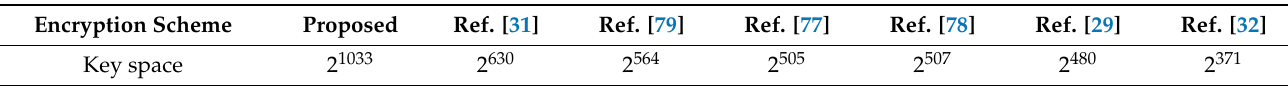
Table 2. Comparison in terms of security key space of recent encryption scheme, including the proposed one.